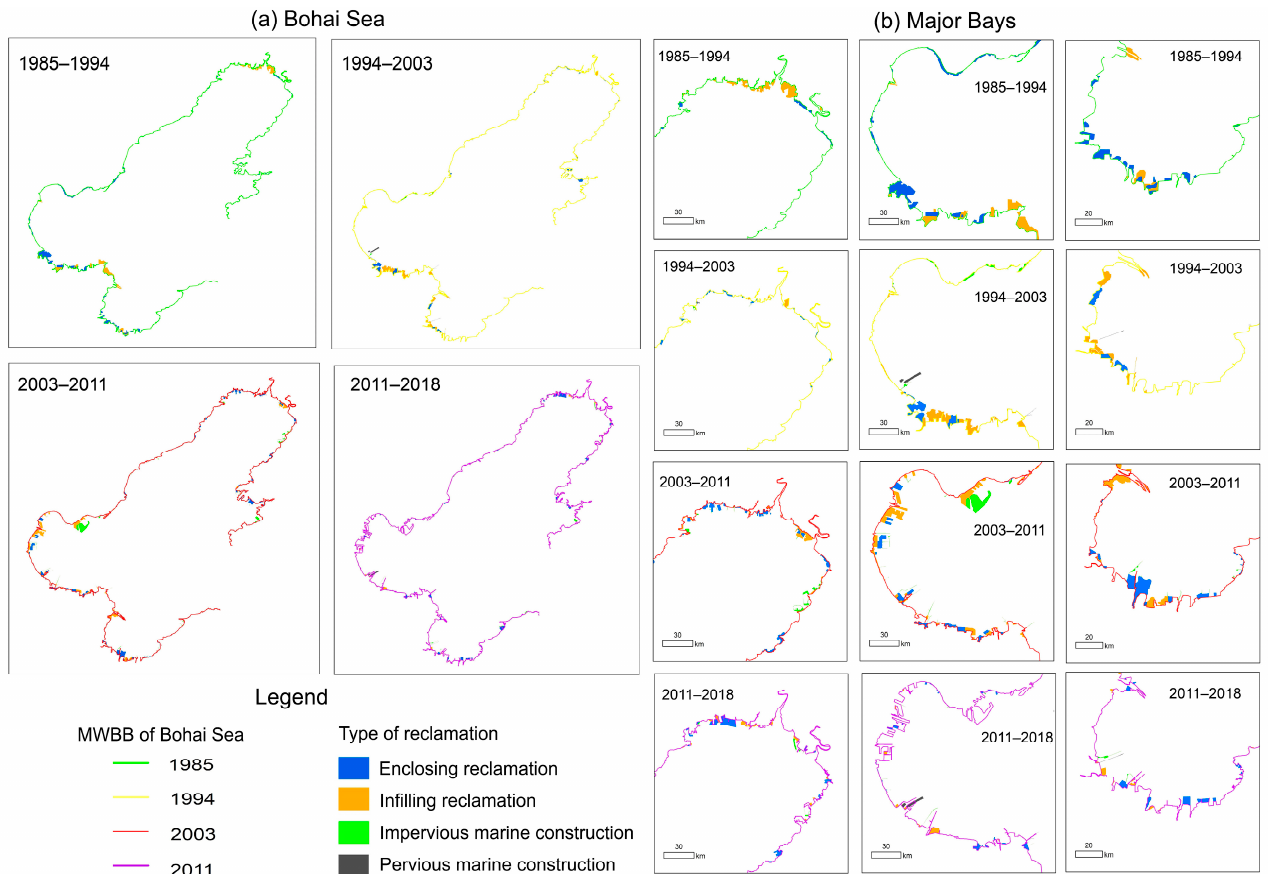
Figure 8. The development process of reclamation in the Bohai Sea.